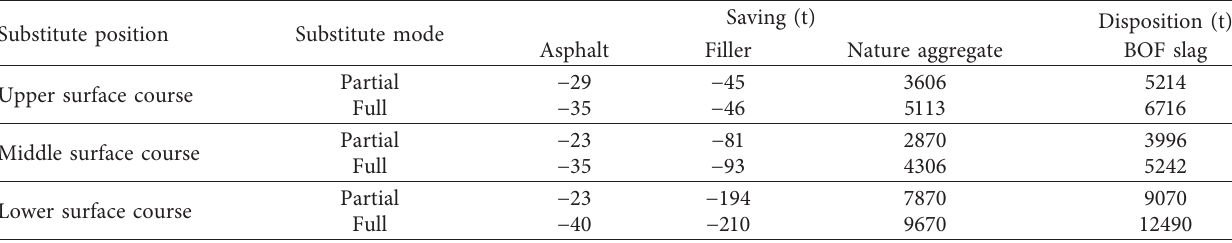
Table 5: Material savings per 10 kilometers of a one-lane road.